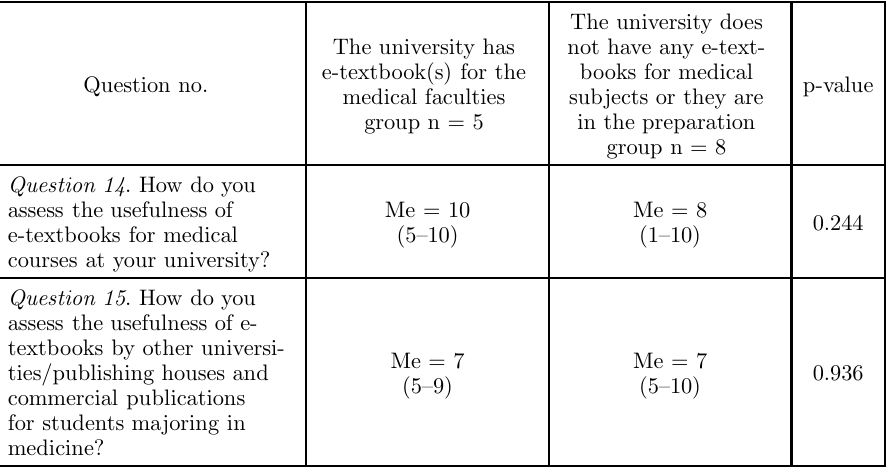
Table 2. Evaluation of the usability of e-textbooks on a scale from 1 to 10